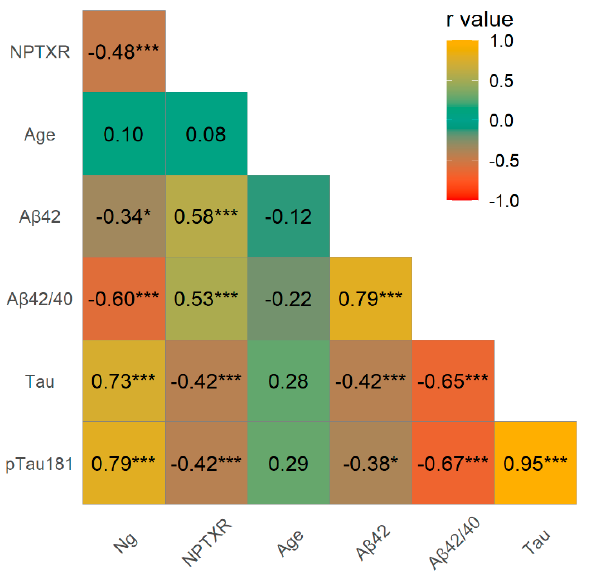
Figure 2. Spearman’s correlations between neurochemical biomarkers and tested proteins in the whole study group. Legend—Level of statistically significant *** p < 0.001, * p < 0.05, Ng—neurogranin, NPTXR—neuronal pentraxin receptor, A β 42—amyloid Beta 1-42, A β 42/40—amyloid Beta 1-42 to 1-40 ratio, AD—Alzheimer’s disease, CTRL—control, CSF—Cerebrospinal fluid. In the AD group, the CSF levels of Ng significantly correlated with NPTXR (rho= − 0.40,